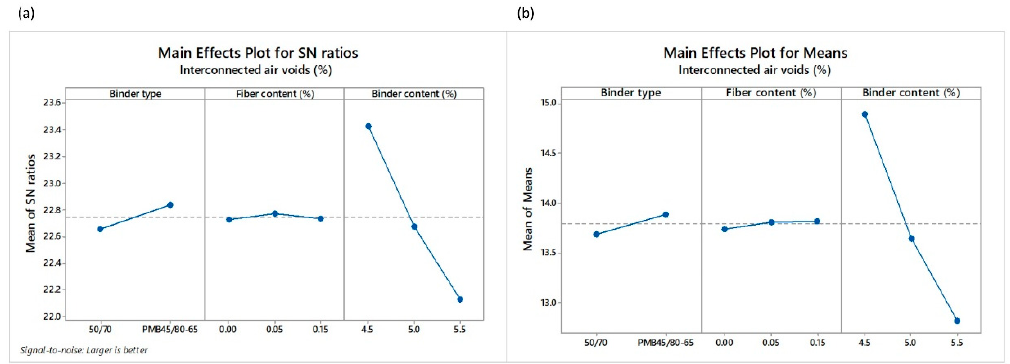
Figure 5. Main effects plots of ( a ) SNR and ( b ) means of the interconnected air voids I AV . Figure 5. Main e ff ects plots of ( a ) SNR and ( b ) means of the interconnected air voids I AV .